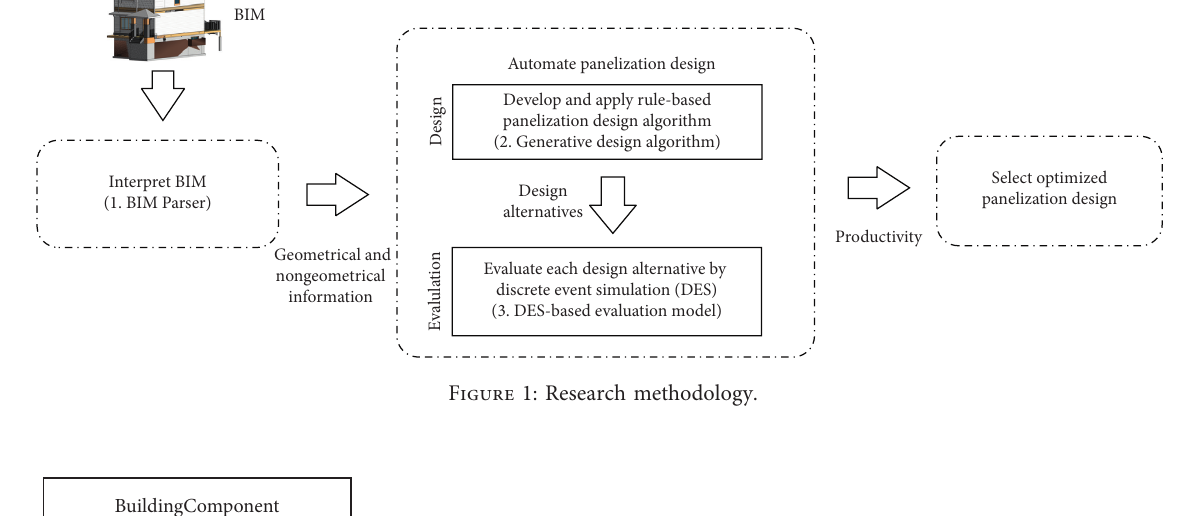
Figure 1: Research